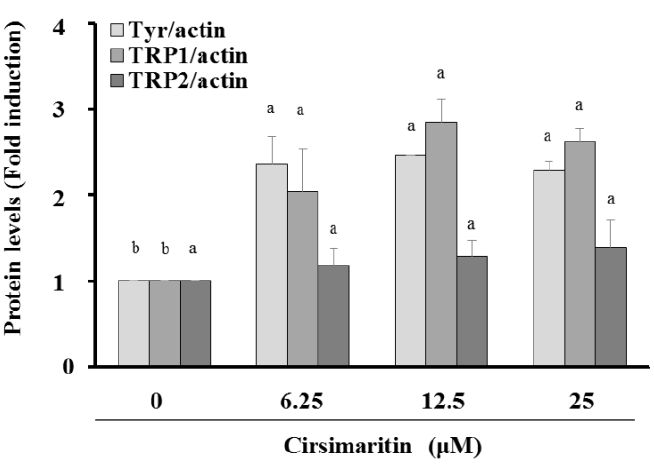
Figure 3. Effects of cirsimaritin on the expression of melanogenic proteins in B16F10 cells. Cells were treated with the indicated concentrations of cirsimaritin for 24 h, and then total cell lysates were subjected to western blotting for detection of tyrosinase, TRP1 and TRP2. The bar graph shows densitometric evaluation of tyrosinase, TRP1 and TRP2 relative to β-actin as the loading control. Results are expressed as the means ± SD of three independent experiments. Means without a common letter differ, p <